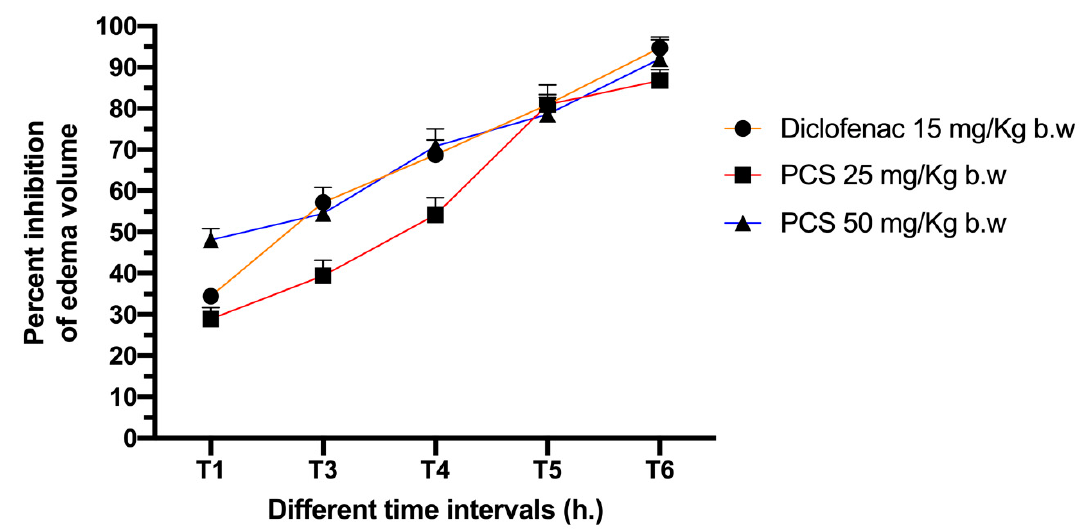
Figure 6. Effect of PCS on edema volume inhibition in carrageenan-induced paw edema Wistar rats.